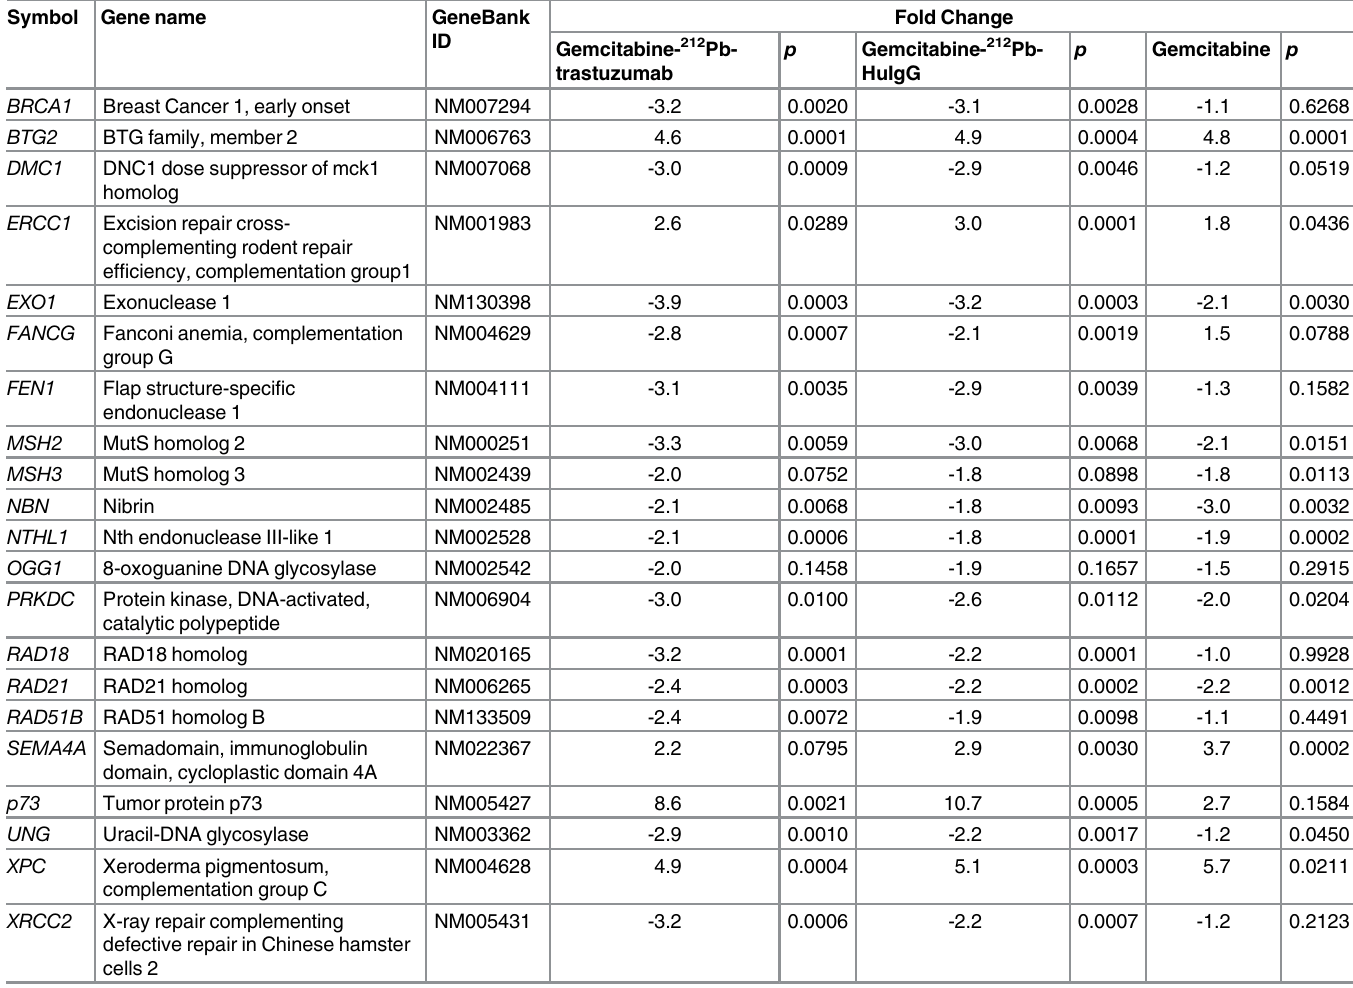
Table 3. Differential expression of gene expression involved in DNA repair in LS-174T i.p. xenografts by Gemcitabine and α